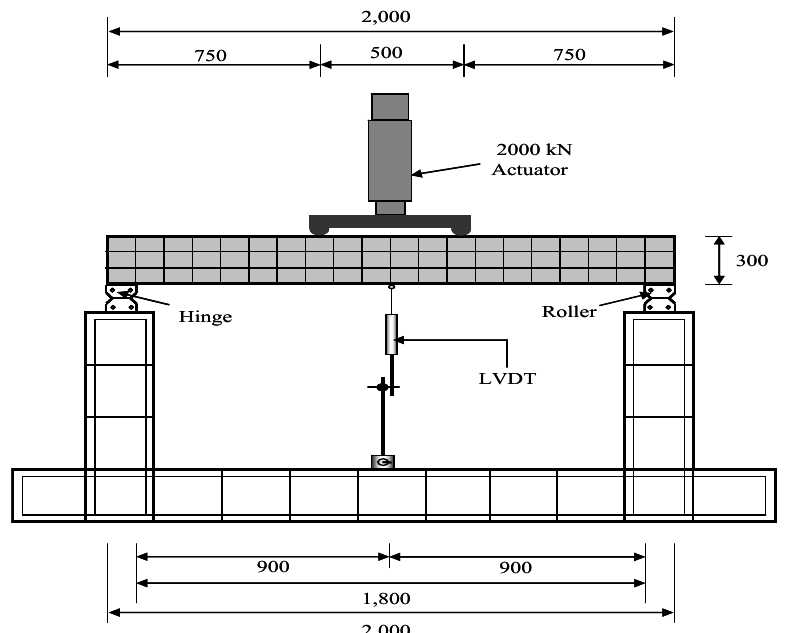
Figure 7. Test setup and data acquisition locations (units: